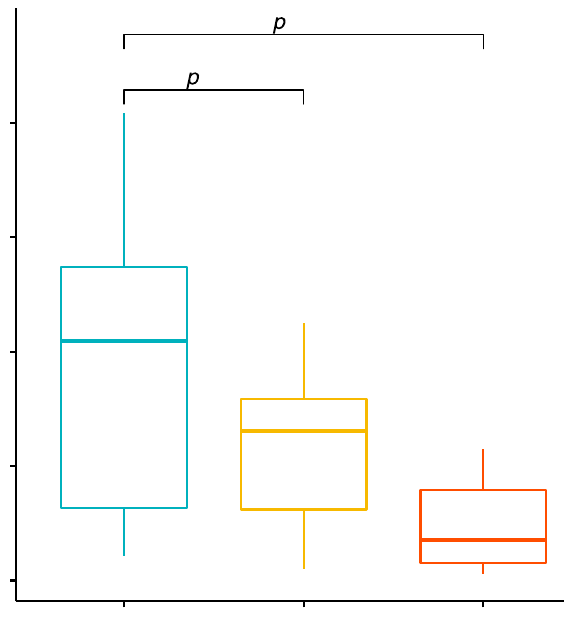
Figure 2. Percentage of CD8 +/ TLR-2 + T lymphocytes (among CD8 + cells) in patients with GD before treatment, after euthyroidism and in the control group.